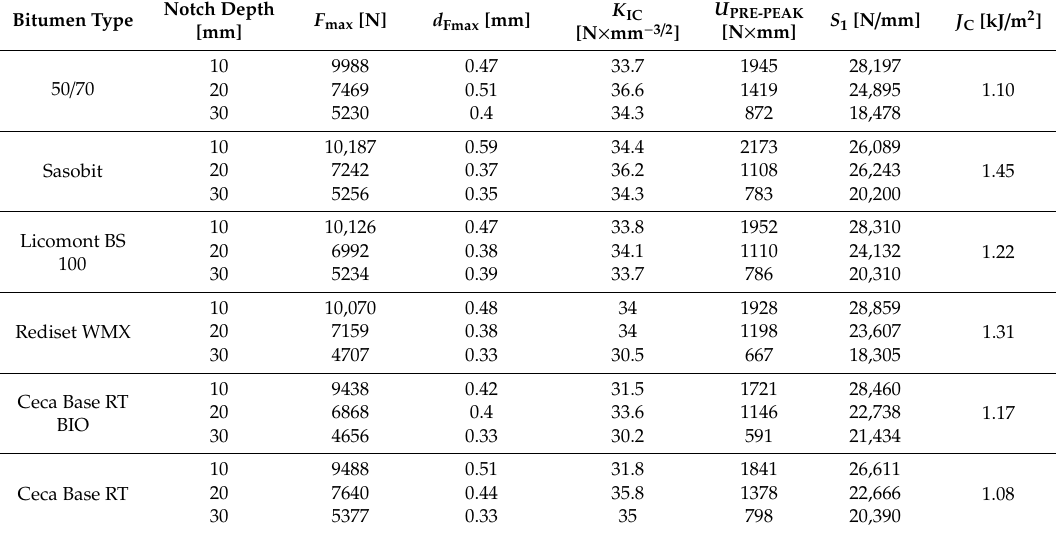
Table 6. SCB test results at − 20 °C.